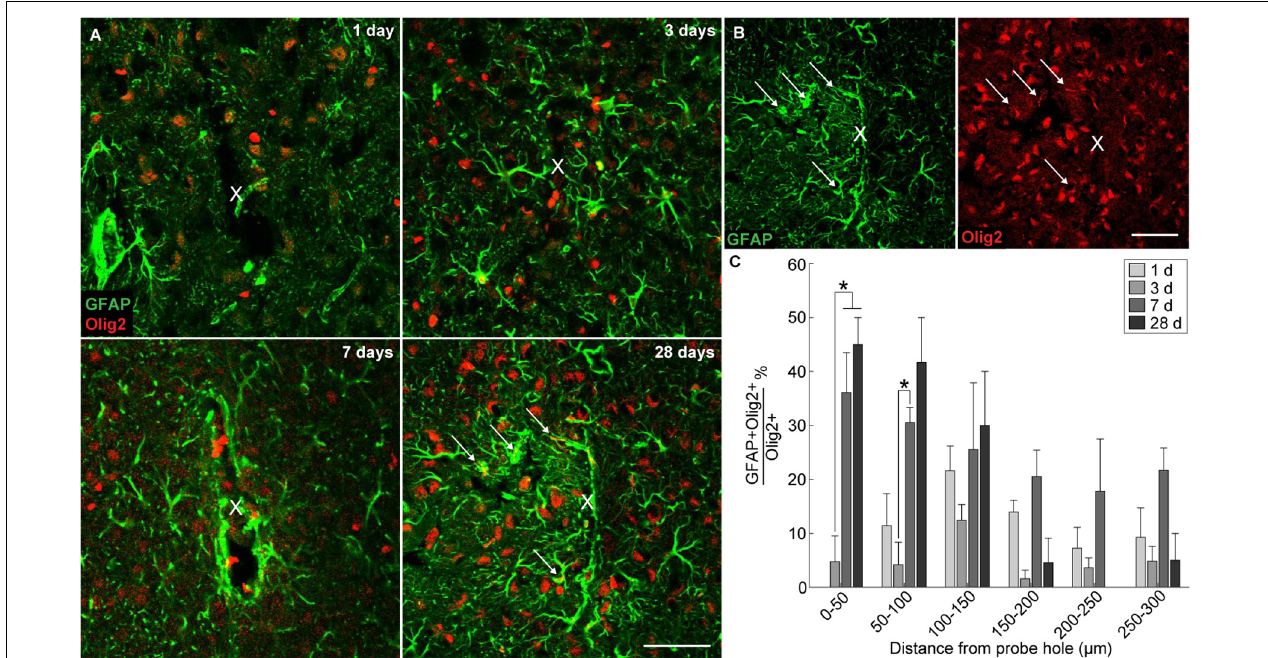
FIGURE 5 | Generation of reactive astrocytes from oligodendrocyte lineage cells around an implanted microelectrode array. Following microelectrode implantation, astrocytes expressed the oligodendrocyte transcription factor Olig2, which may implicate oligodendrocyte lineage cells as a source of astrocytes following injury. (A) Representative immunohistochemical stains for GFAP (green) and Olig2 (red) at 1, 3, 7, and 28 days post-insertion revealing a distinct subpopulation of Olig2+GFAP+ astrocytes. White arrows denote co-localized cells. Center of the probe hole is denoted by a white “x.” Scale bar = 50 µ m. (B) Green- and red-only channels for GFAP and Olig2 staining, respectively, at 28 days post-insertion. White arrows denote GFAP+ (left) or Olig2+ (right) cells. Center of the probe hole is denoted by a white “x.” Scale bar = 50 µ m. (C) Percent of GFAP+Olig2+ cells over total Olig2+ cells within 50 µ m bins up to 300 µ m away from site of insertion suggest preference for Olig2+GFAP+ cells to reside near site of probe implantation. ∗ indicates p < 0.05.